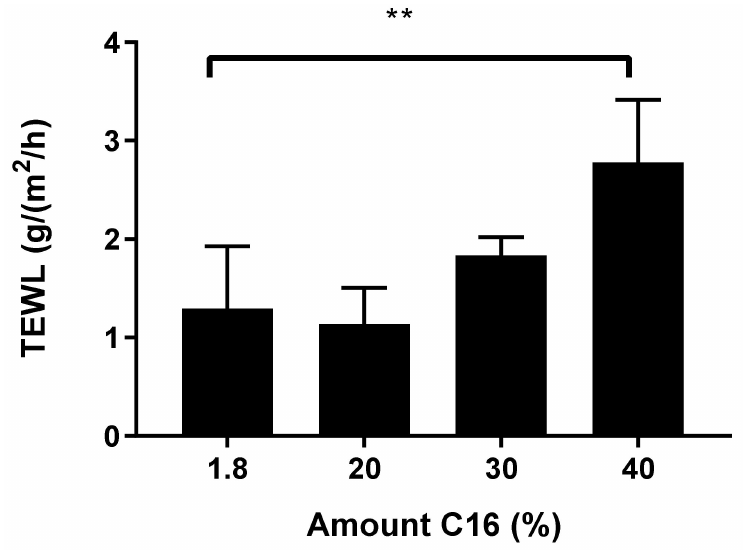
Figure 7. The steady-state flux values from TEWL measurements across the model membranes with different percentages of FFA C16 content in relation to the total FFA content. When the FFA C16 was increased from 1.8 to 40%, the flux was statistically higher, n = 4 ** p <